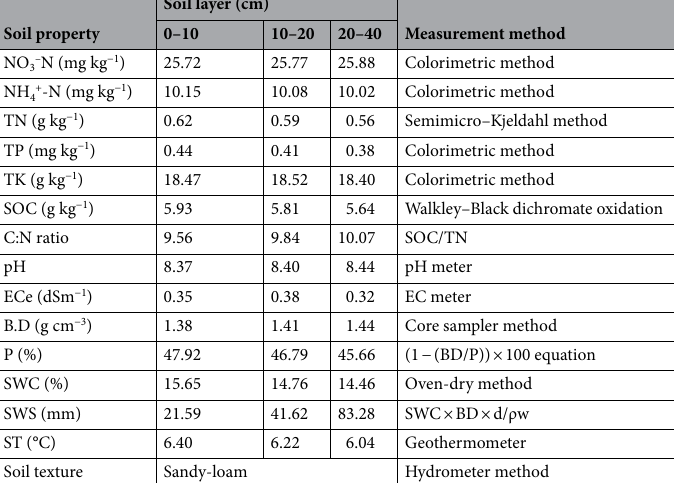
Table 1. Soil physical and chemical properties before sowing. P.D: particle density = (2.65 g cm −3 ). ρw density of water, d soil depth, NO 3– N nitrate nitrogen, NH 4+ -N ammonium nitrogen, TN total nitrogen, TP total phosphorous, TK total potassium, SOC organic carbon, C:N ratio soil carbon and nitrogen ratio, pH soil pH, ECe electrical conductivity, B.D soil bulk density, P soil porosity, SWC gravimetric soil water content, SWS soil water storage, ST soil